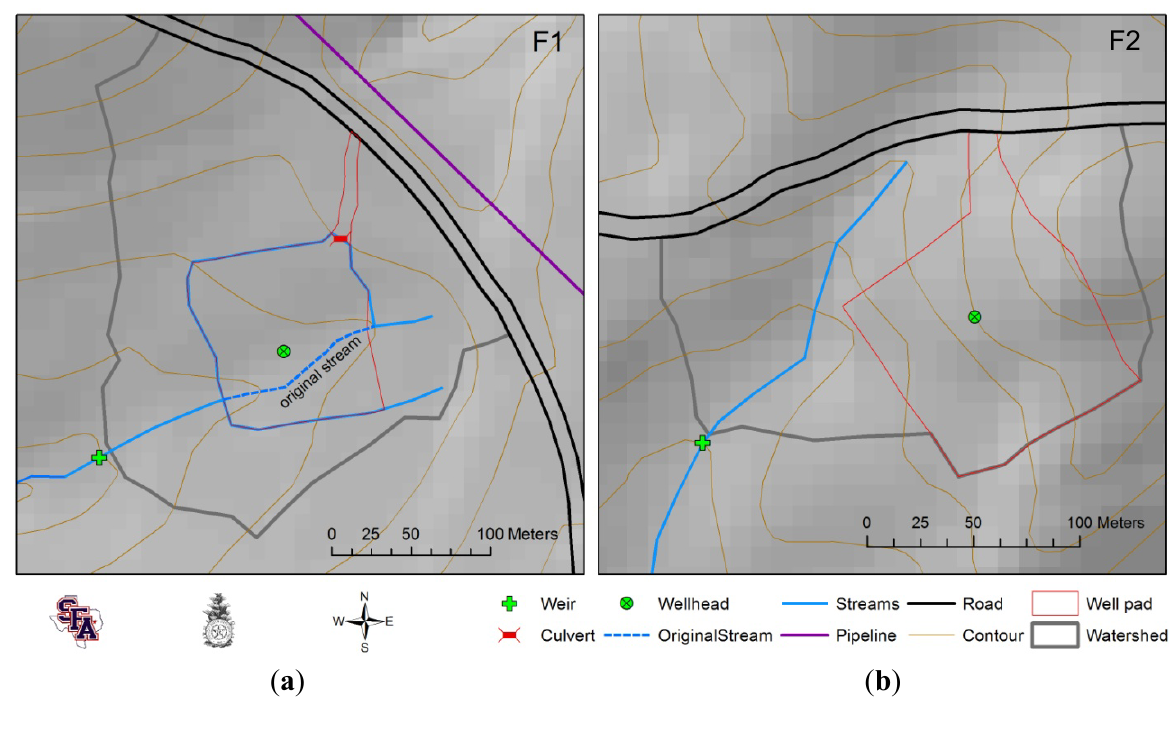
Figure 2. F1 ( a ) and F2 ( b ) natural gas well pad layout at the Alto Experimental Watersheds, Texas,